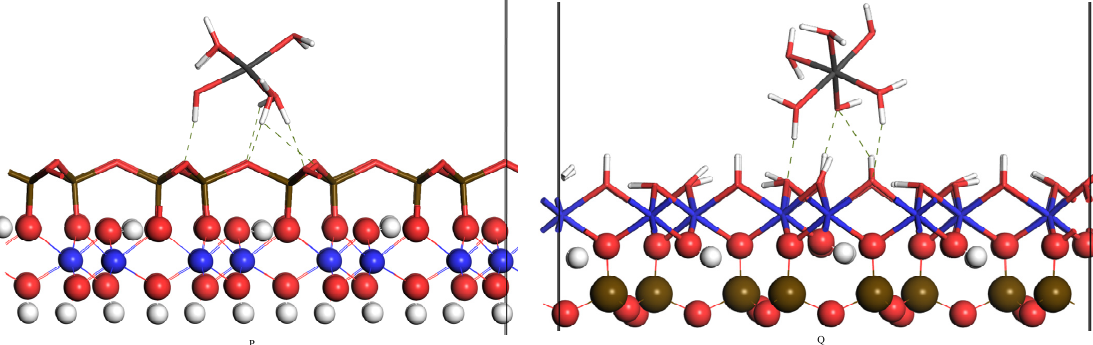
Table 3. Bond length (Å) and adsorption energies (KJ/mol) of Fe(OH)(H 2 O) 52+ . Form